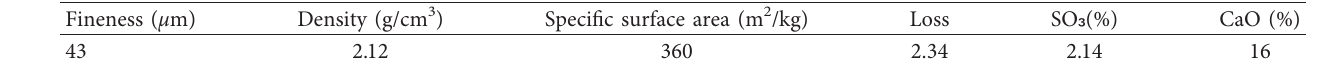
Table 2: Properties and chemical composition of fly ash.